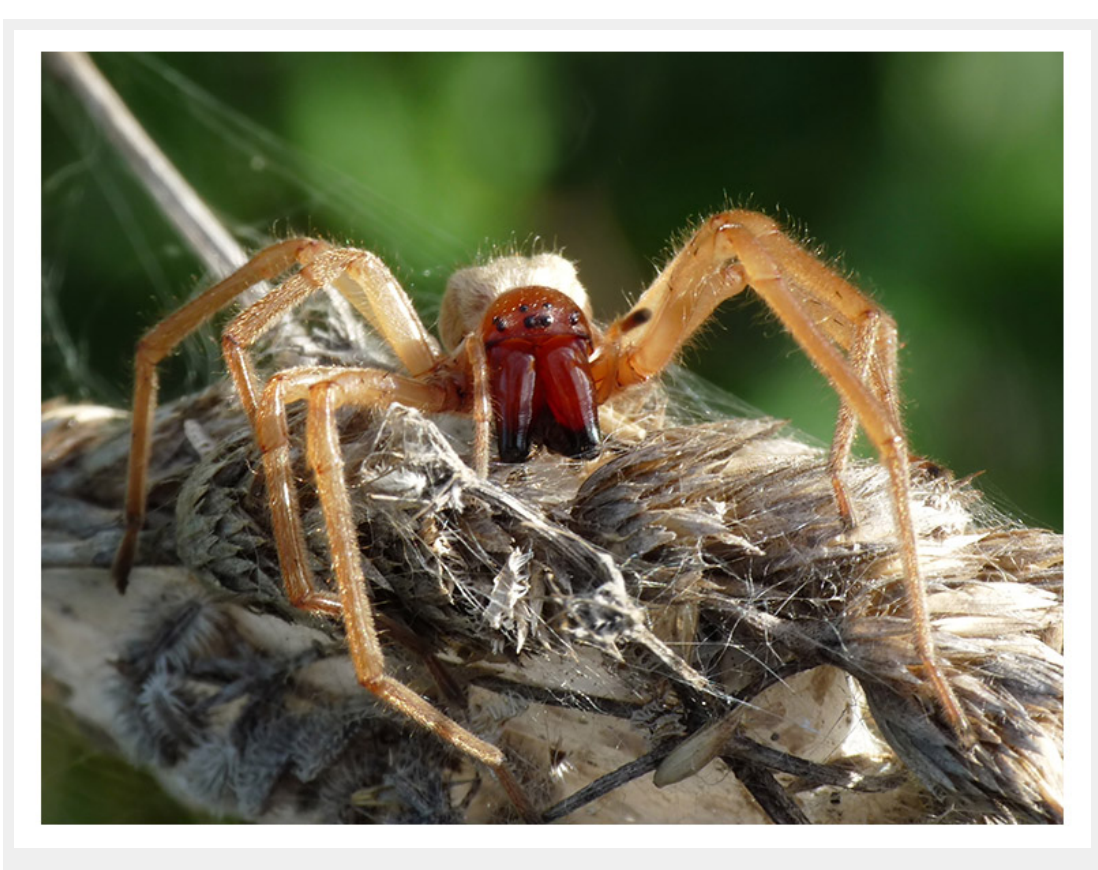
Figure 3 Cheiracanthium punctorium, female (source: Lucarelli, Wikimedia